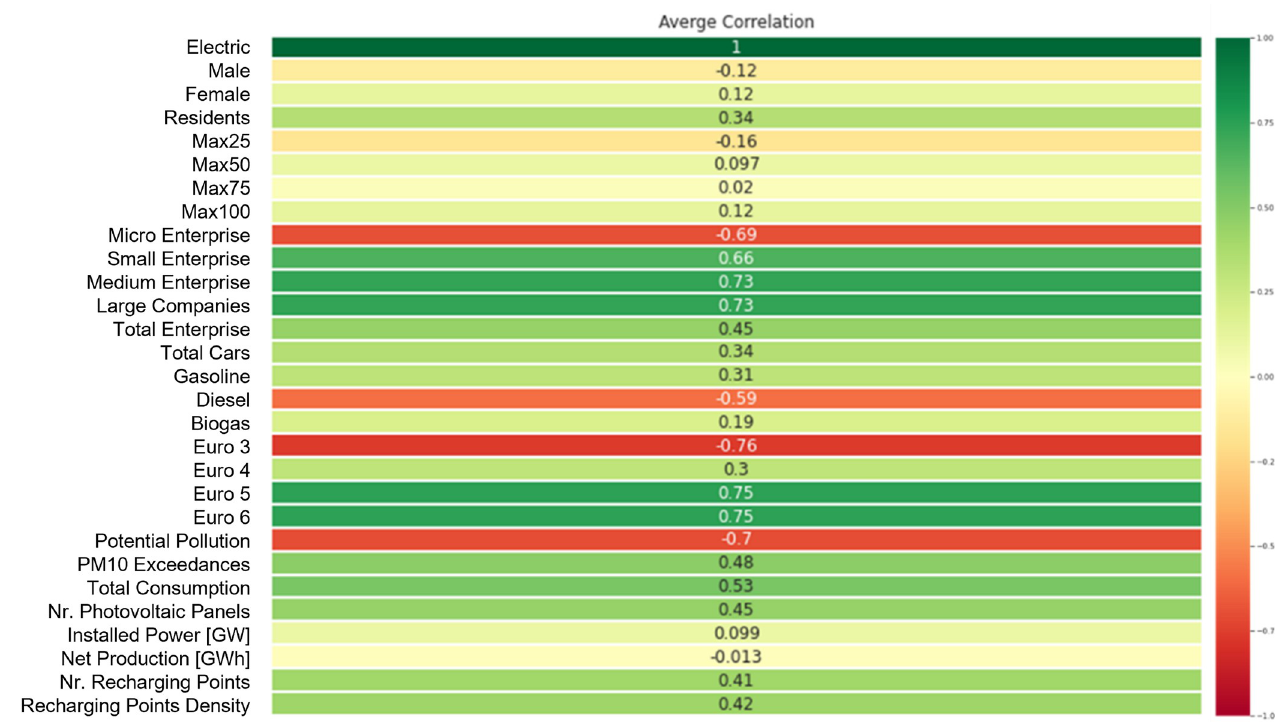
Fig 5. Provincial features average correlation with the target variable (provincial percentage of EVs). The average is computed as the mean value of yearly correlations. Values are included in the range [–1,1].